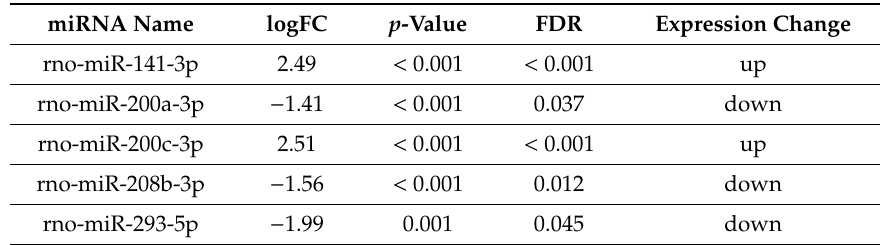
Table 1. Di ff erentially expressed miRNAs from left ventricular samples. LogFC, base 2 logarithm of the fold change; p -values were calculated by the edgeR software package using likelihood ratio tests after applying generalized linear models (GLM) to estimate dispersions. FDR, false-discovery rate (adjusted p -value according to Benjamini and